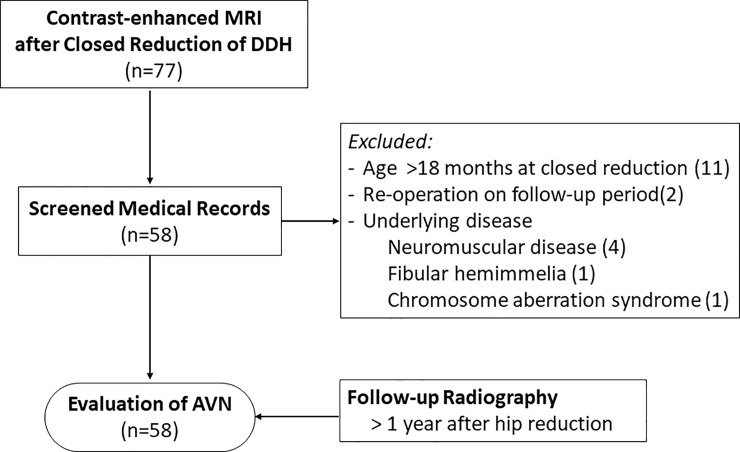
Flow chart of the study inclusion.